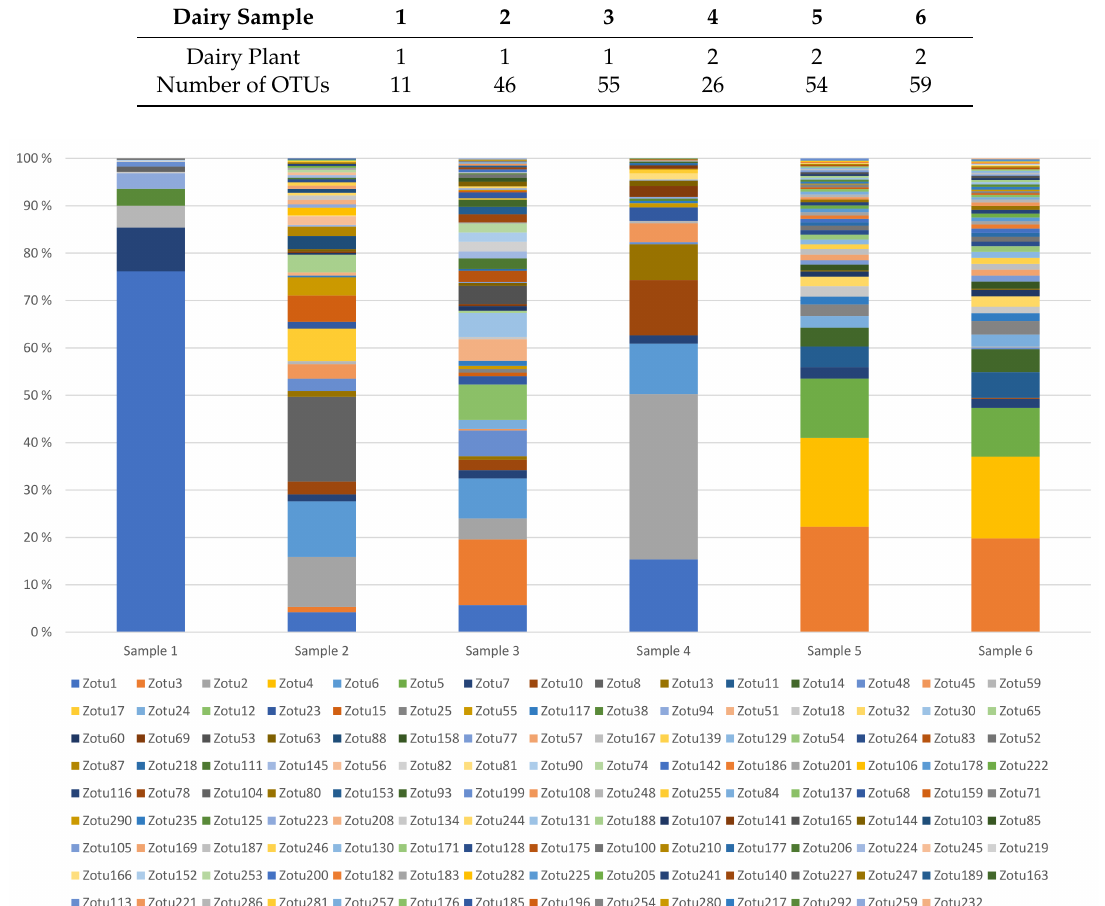
Table 1. Diversity of 936 phages in dairy samples from two Norwegian dairy plants; OTU, operational taxonomic unit.